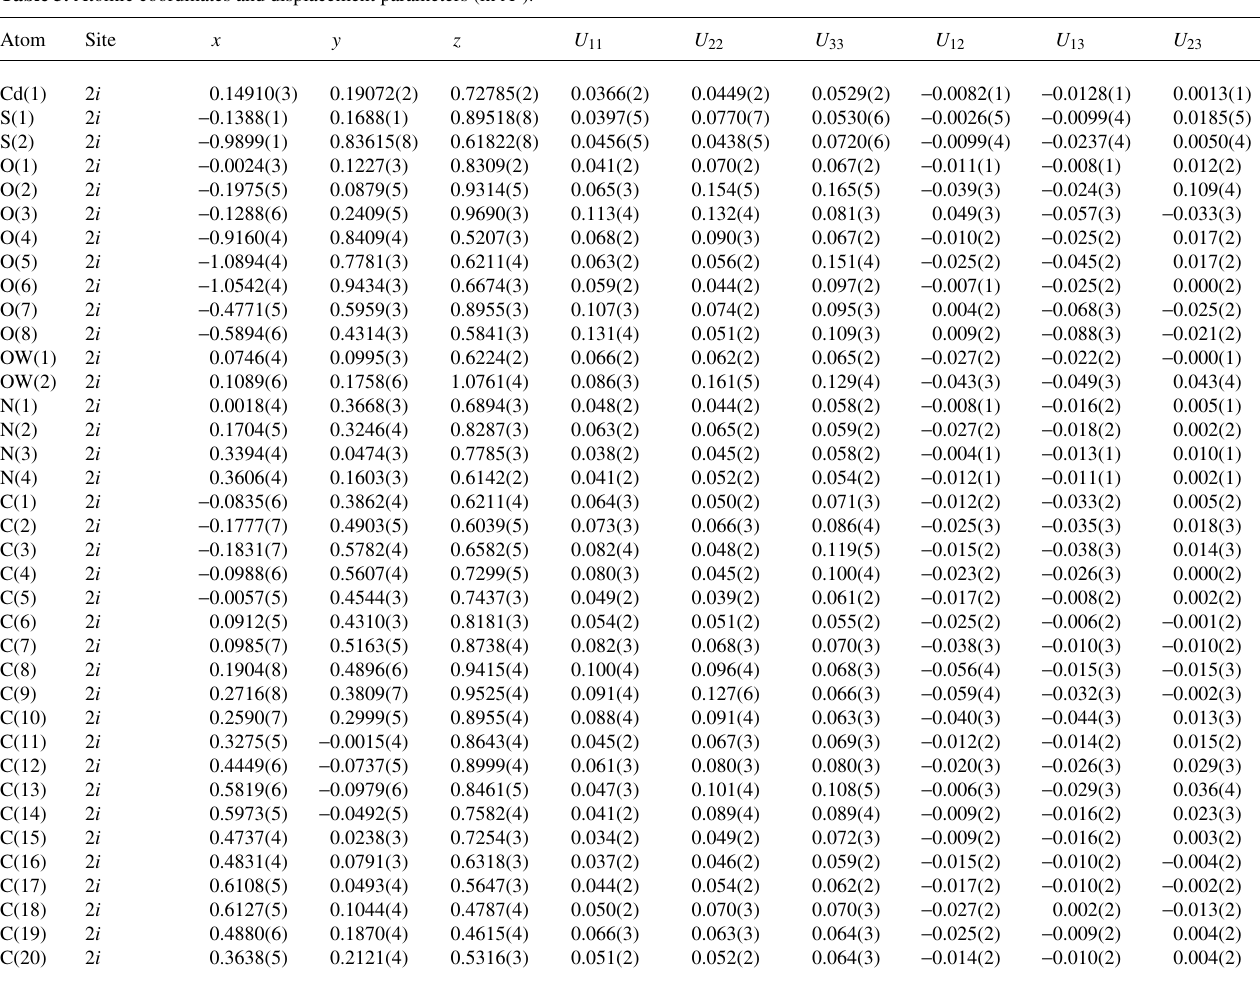
Table 3. Atomic coordinates and displacement parameters (in Å 2 ) .